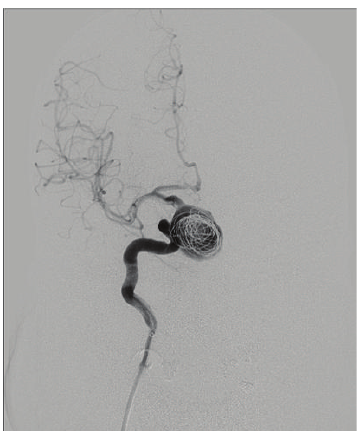
Figure 1: Coronal T2-weighted MR image showing giant saccular aneurysm.